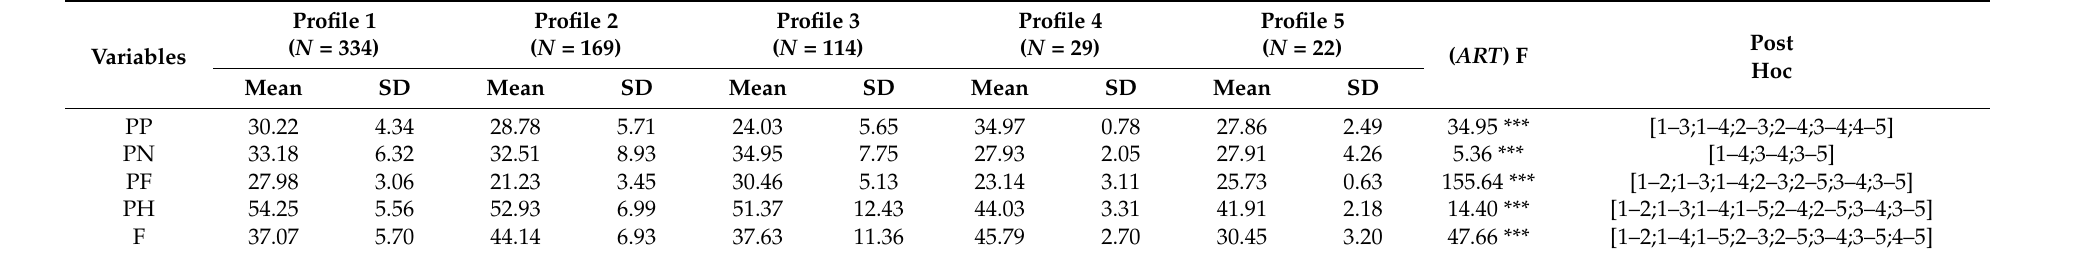
Table 2. Means and standard errors for the five profiles identified through LPA ( N = 668).